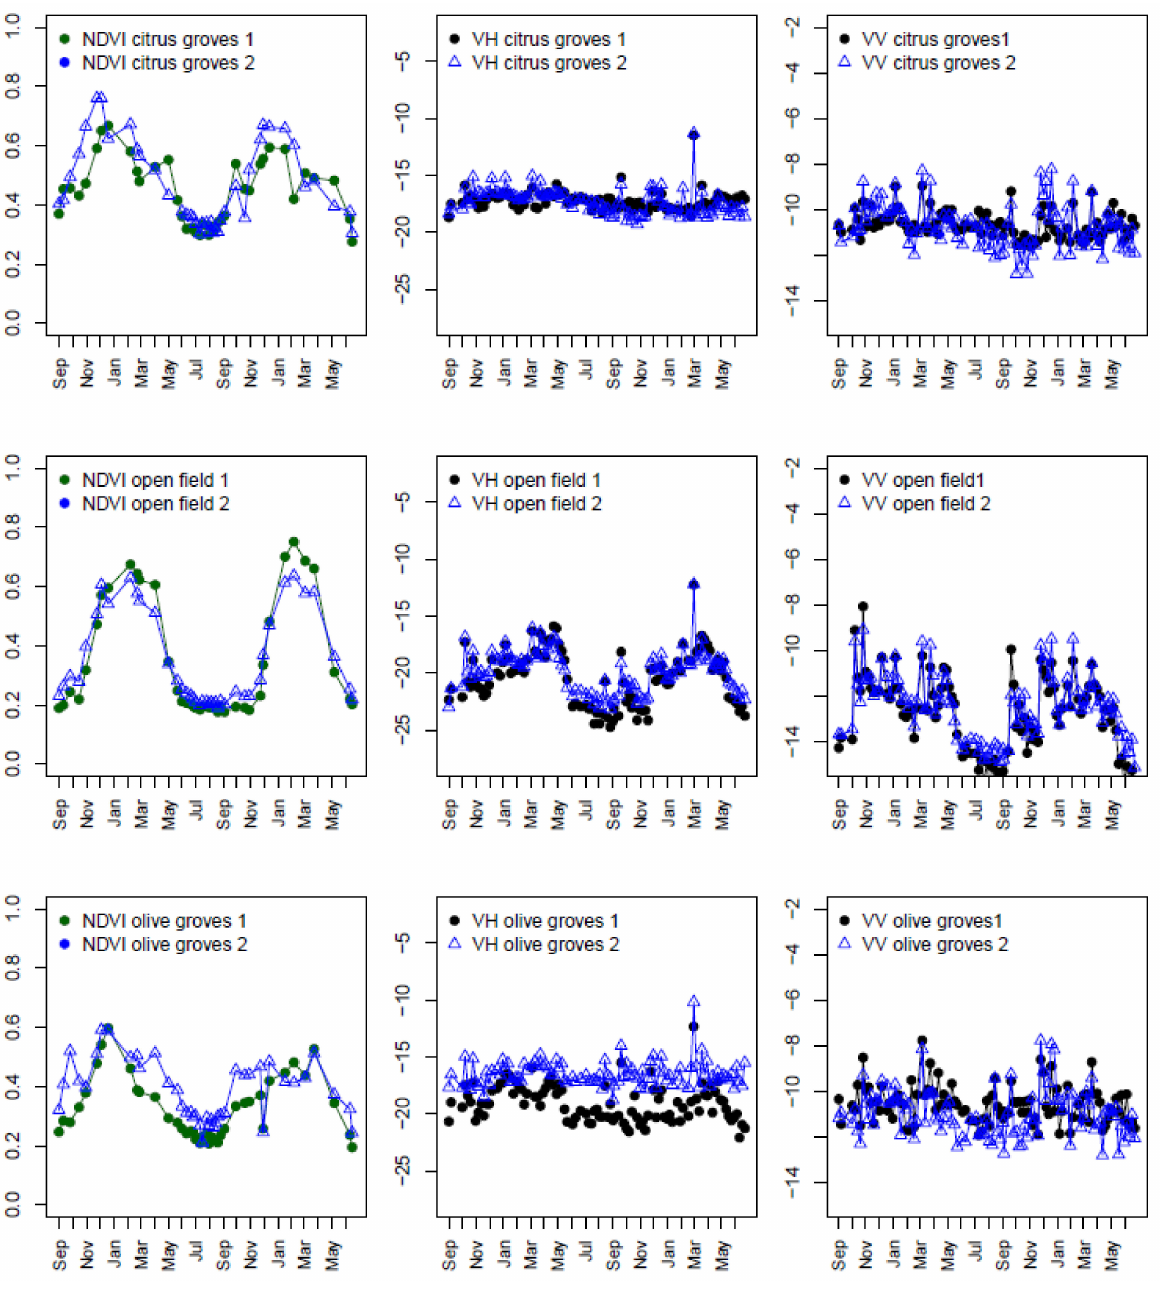
Figure 7. Temporal signatures of purple citrus, open field and olive for NDVI, VH and VV. The open field class included annual crops, predominantly cereals (wheat and barley) and fallow. In the Cap Bon region, the cereals are seeded at the outset—mid-September— and reach their maximum in March–April and the phenological cycle finishes by the end of May. The harvest always starts with the month of June. Generally, fallow acts